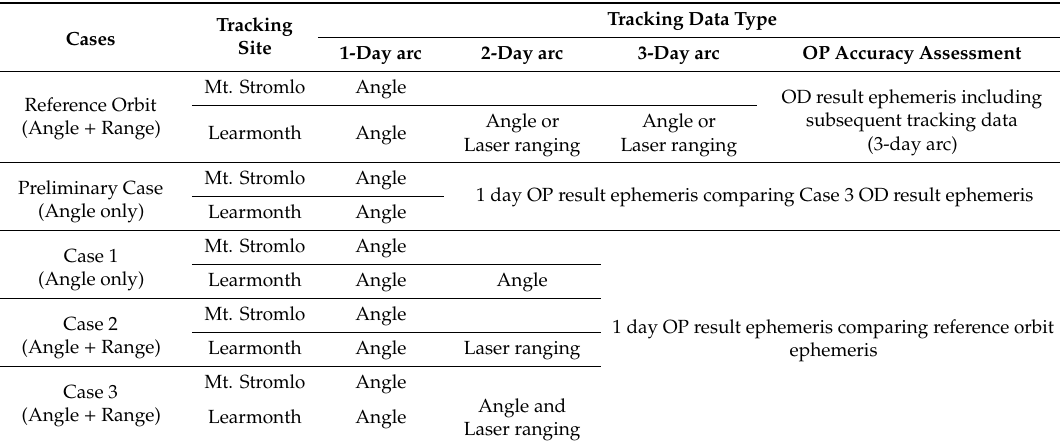
Table 6. The descriptions of OD / OP Cases with the OP accuracy